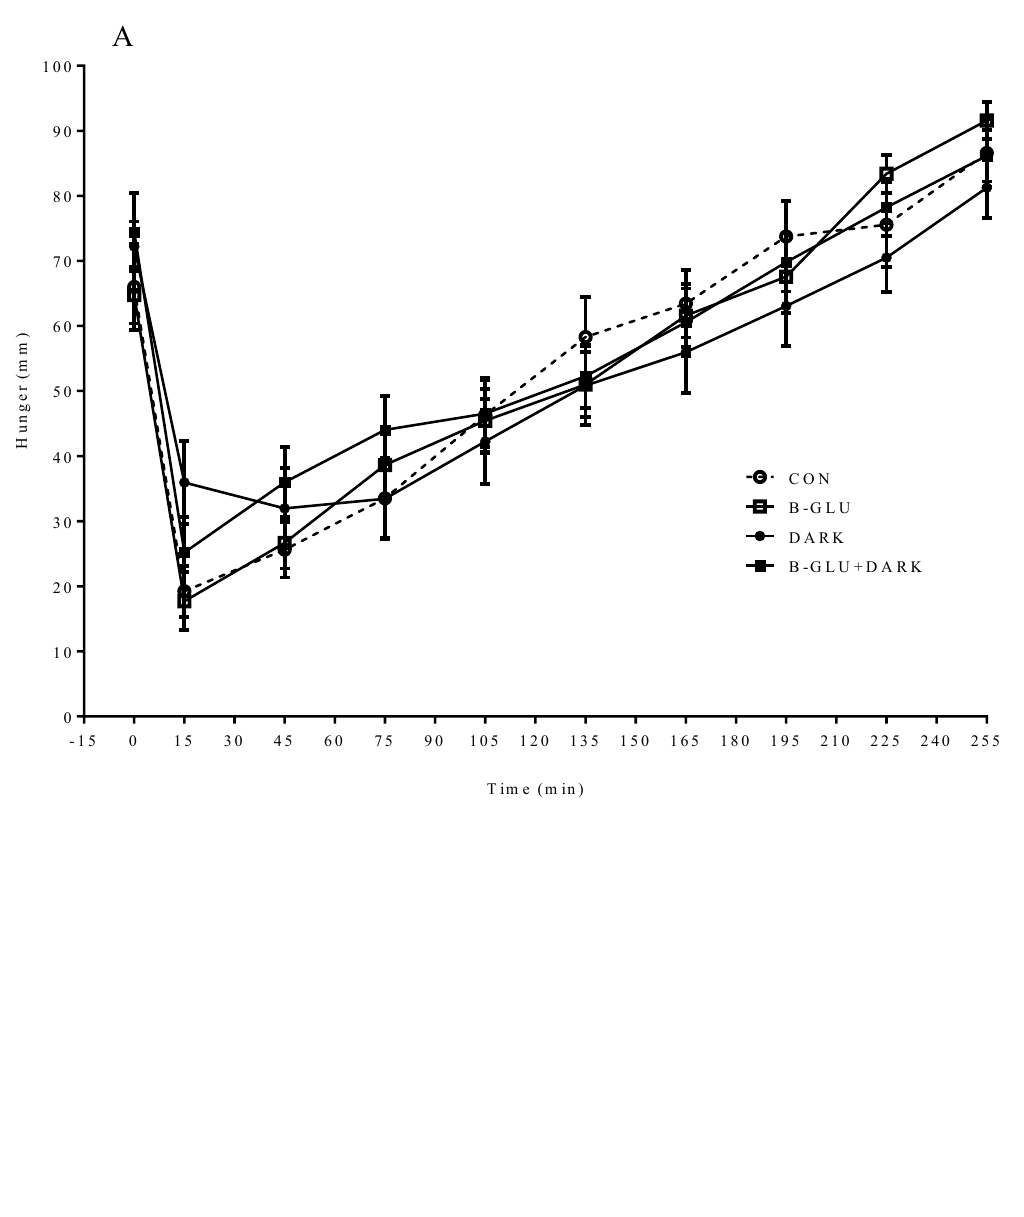
Figure 1. Mean VAS scores during the four test days. Mean VAS scores (±S.E.M.)